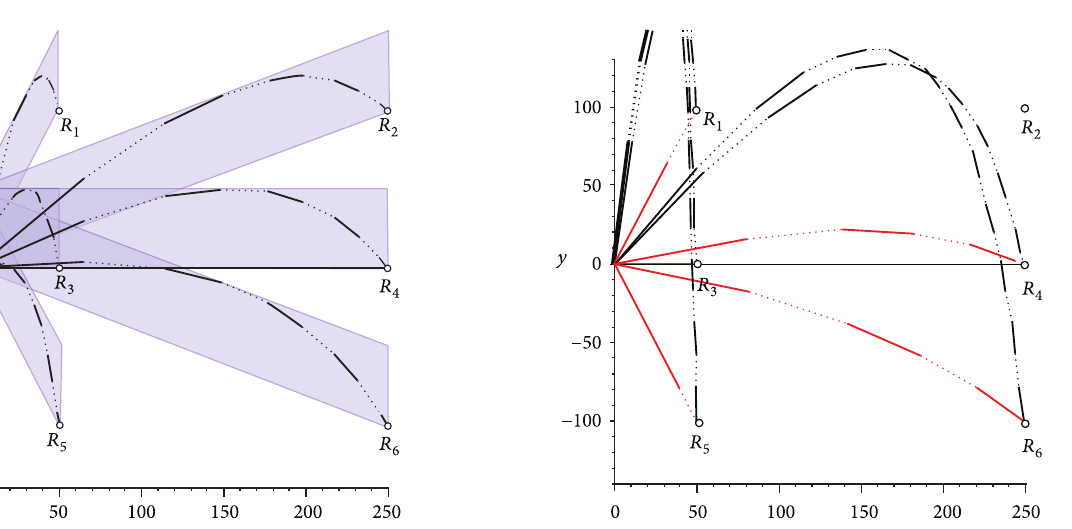
Figure 16: Planning trajectories through six different 𝑅 s, all starting at 100m/s. Each of the five reachable targets has a trajectory with a (red) low arc and a (black) high